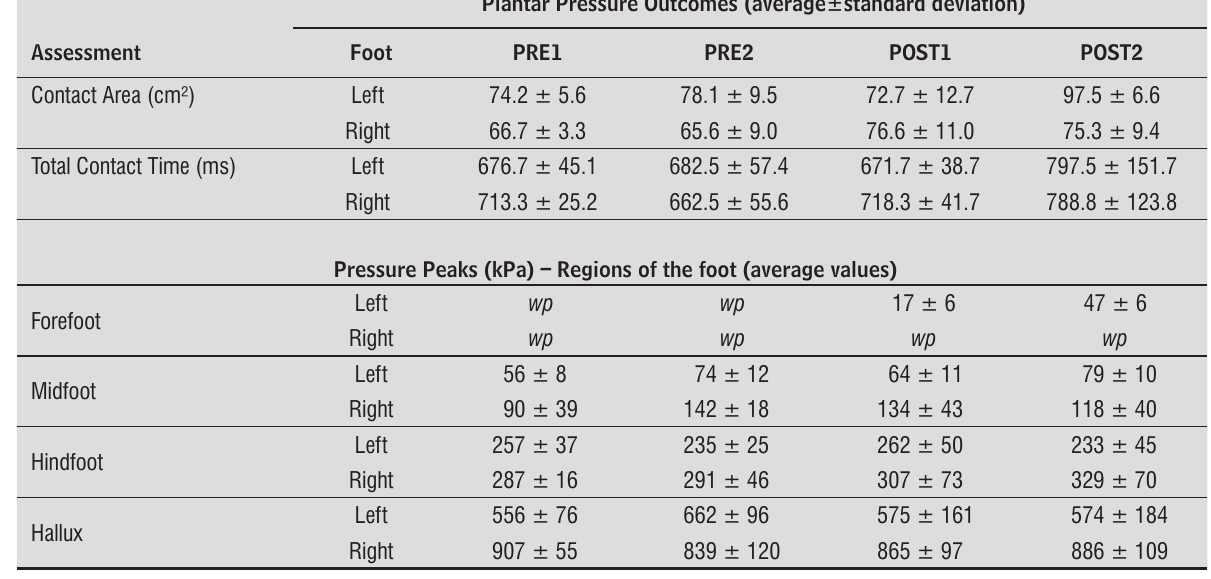
Table 2 - Data on the plantar pressure distribution during gait Plantar Pressure Outcomes (average±standard deviation)